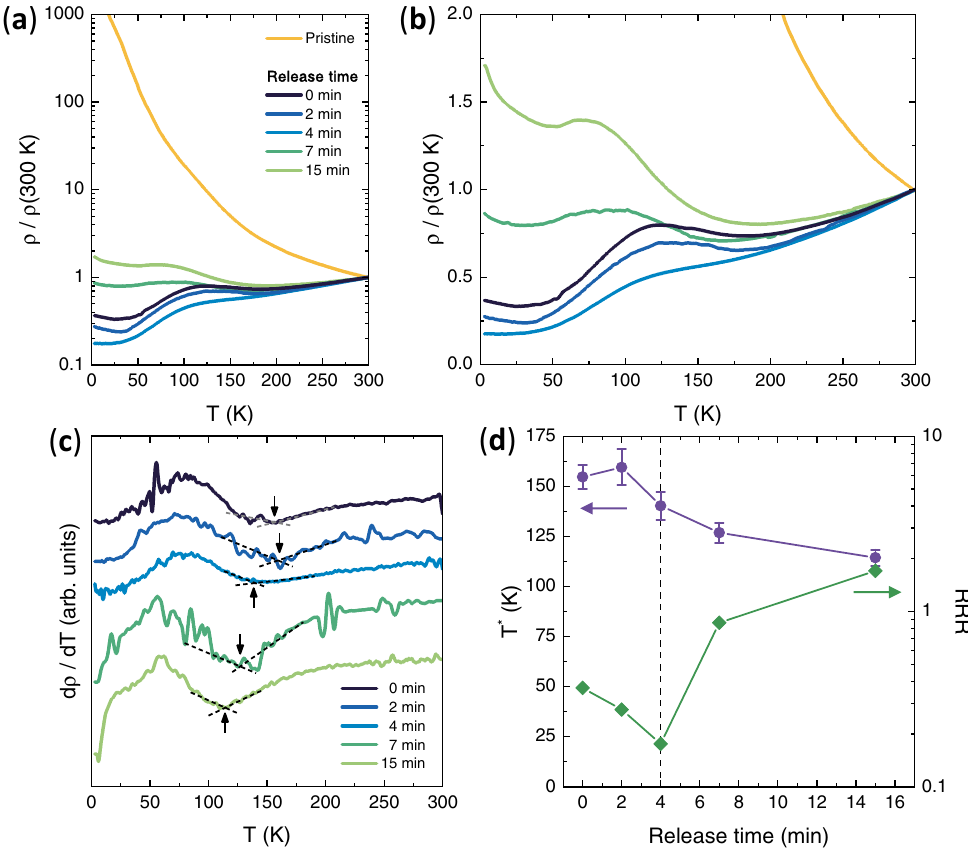
Figure 5. Temperature dependence of the electric transport in pristine and intercalated MoS 2 . ( a ) Re- sistivity ρ divided by its value at 300K as a function of temperature T , before and after EMIM intercalation, in semi-logarithmic scale. ( b ) same as in ( a ) but on a linear scale. ( c ) T dependence of d ρ / dT , before and after EMIM intercalation, obtained by numerical derivation of the curves in ( b ). Arrows highlight the values of T where d ρ / dT shows a dip ( T ∗ ). The curves are vertically offset for clarity. ( d ) T ∗ (violet circles, left scale) and residual resistivity ratio ρ (green diamonds, right scale) as a function of the release